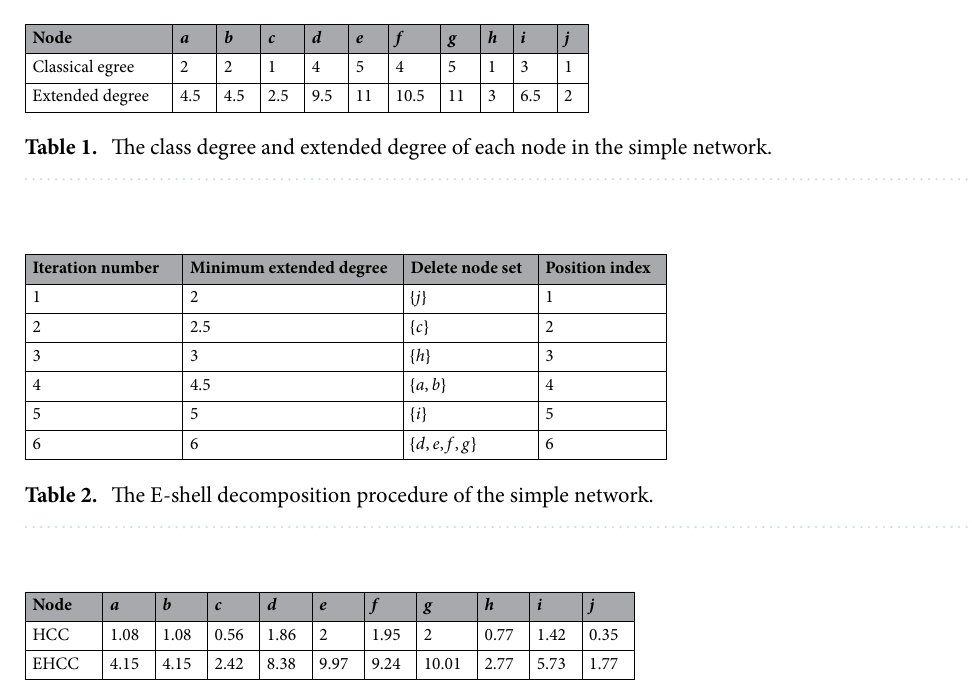
Table 3. The results of EHCC and HCC for the simple